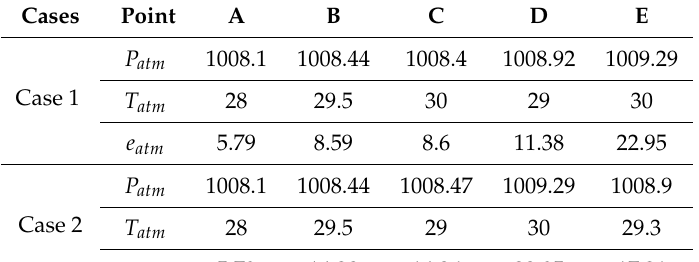
Table 4. The meteorological parameters of BTD errors.